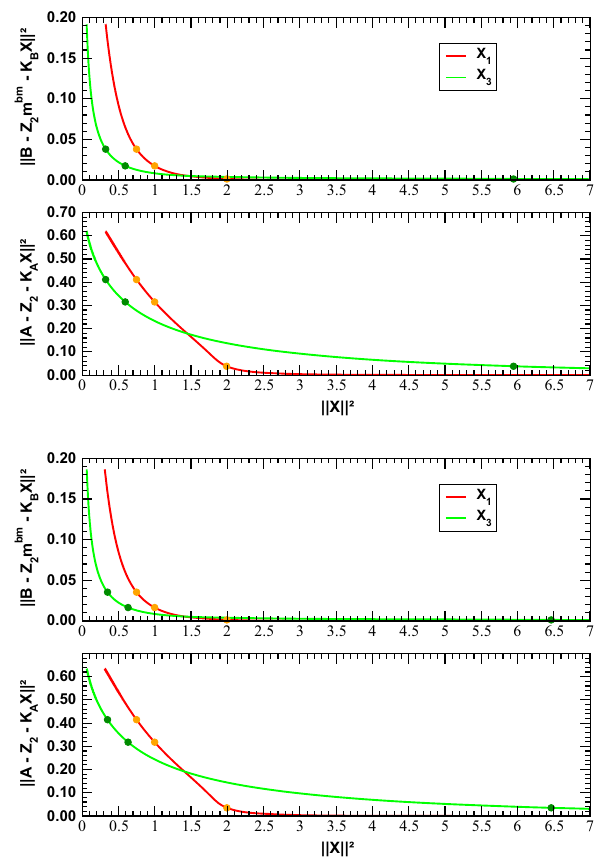
Fig. 13 Residuumversusnormforthescalarandvectorequationwhen solving the gap equation for X 1 and X 3 with X 0 as given by one-loop dressed perturbation theory. The left plot refers to the inversion using H 1 ( q 2 ) = 1, while the right plot are the results for the inversion using the improved gluon-ghost vertex. Smaller values of the regularising parameter (cid:19) are associated to solutions with larger norms, while larger values of (cid:19) produce Y 1 and Y 3 with smaller norms. Recall that Y 1 has mass dimensions, while Y 3 is